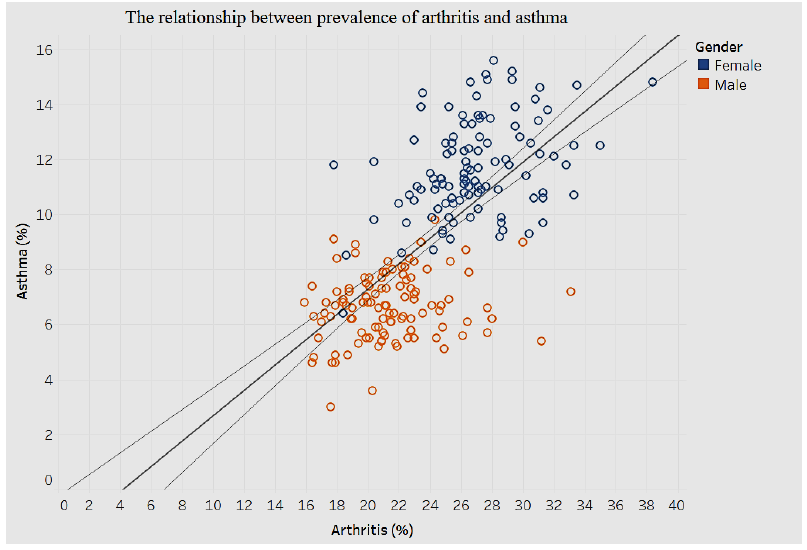
Figure 26. Arthritis by asthma.